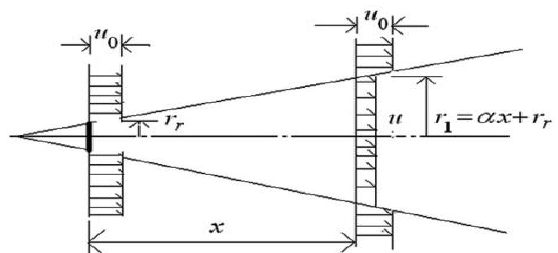
Figure 6 . Schematic diagram of Jensen’s wake model (Grady et al.,